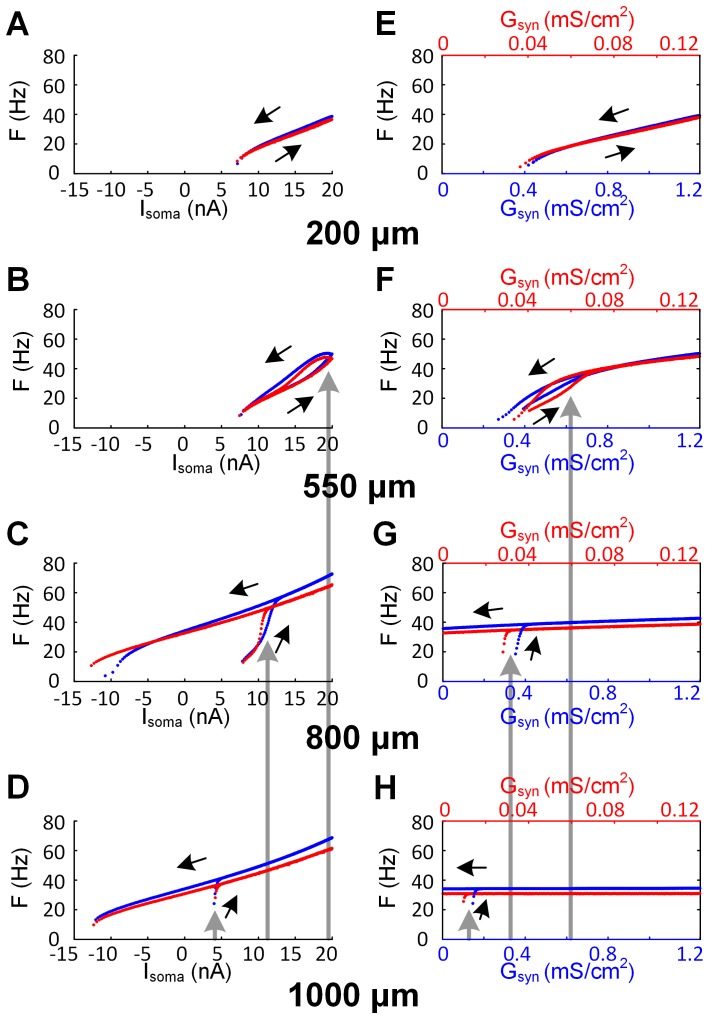
Cellular excitability of the anatomical (blue) and reduced (red) model with different locations of PIC channels in the dendrites.The neuron models and stimulation protocols were the same as those used in Figure 2(H) & (I) except for variation of PIC channel location in the dendrites. (A) – (D). Firing rates (F) in response to triangular current stimulation to the soma (Isoma). (E) – (H). Firing rates (F) in response to triangular variation of maximum conductance (Gsyn) of excitatory synaptic receptors in the dendrites. The direction of black arrows indicates the ascending and descending phase of triangular current stimulation and change in Gsyn. The gray arrows indicate the current and Gsyn threshold for activating plateau potentials at different distances from the soma. Note the negative relation between the distance and input threshold. At different locations in the dendrites, the three VA factors were VASD
DC = {0.91, 0.77, 0.69, 0.63}, VADS
DC = {0.96, 0.79, 0.57, 0.38} and VASD
AC = {0.65, 0.31, 0.18, 0.12}; the density of Ca PIC channels were GCa,L = {1.14, 1.27, 1.95, 4.1 mS/cm2} in the anatomical and {0.11, 0.122, 0.132, 0.189 mS/cm2} in the reduced model; the passive parameter values of the reduced model were Gm,S = {0.078, 0.132, 0.174, 0.2 mS/cm2}, Gm,D = {0.179, 0.143, 0.1, 0.07 mS/cm2}, GC = {0.918, 0.244, 0.114, 0.06 mS/cm2}, Cm,S = {0.609, 1.077, 1.211, 1.302 µF/cm2}, Cm,D = {1.239, 0.903, 0.764, 0.62 µF/cm2}. Parameter values in the parentheses are in the order of increasing distance from 200 to 1000 µm.